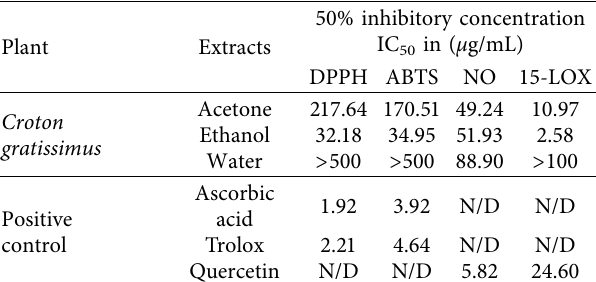
Table 5: DPPH and ABTS assays show antioxidant activity and NO and 15-LOX show anti-inflammatory properties of Croton gra- tissimus leaf extracts against the standards’ ascorbic acid, Trolox, and quercetin